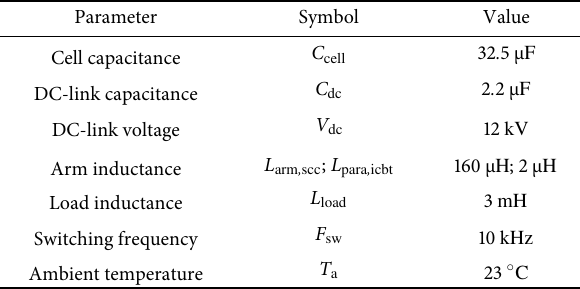
Table 3 Parameters of the MV converter in pumpback